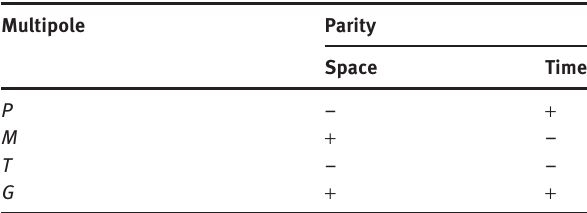
Table 1: Transformation properties of electric (P), magnetic (M), polar toroidal (T), and axial toroidal (G) moments under space inver- sion and time reversal